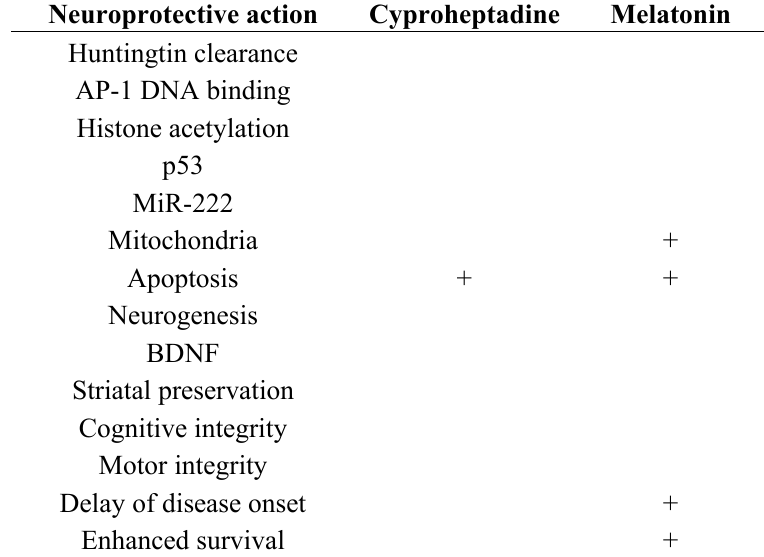
Table 9. Anxiolytic and hypnotic neuroprotective effects in Huntington’s disease